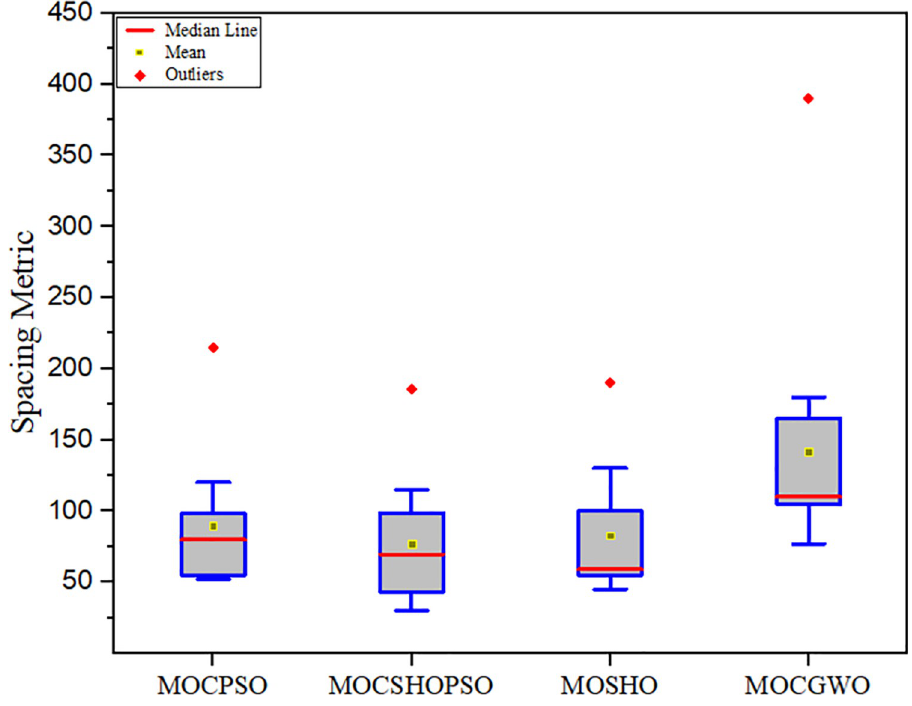
Fig 6. Box plot, driven from the spacing metric